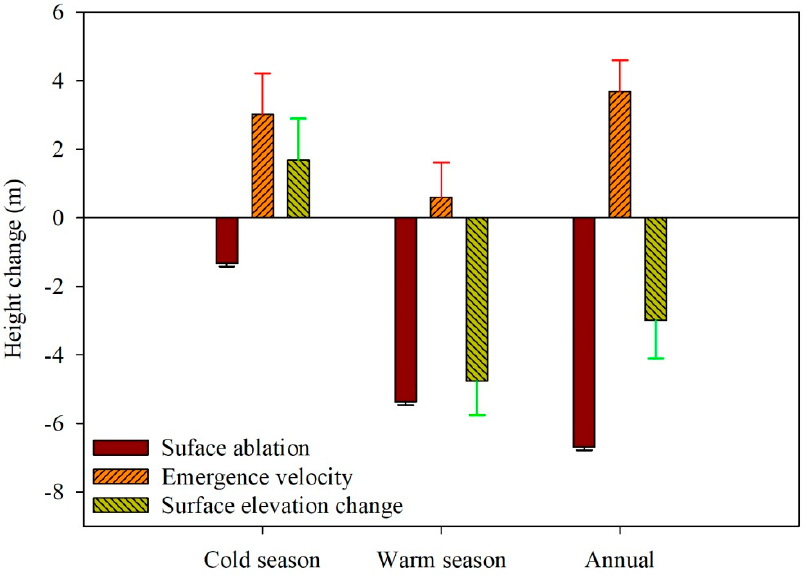
Figure 9. Mean change of in situ stakes measuring surface lowing due to ablation ( ∆ h), UAV-SfM orthomosaic-derived ice surface elevation change ( δ H / δ t) and emergence velocity ( ∆V ↑ ), which were averaged at the five stake locations over seasonal and annual timescales.